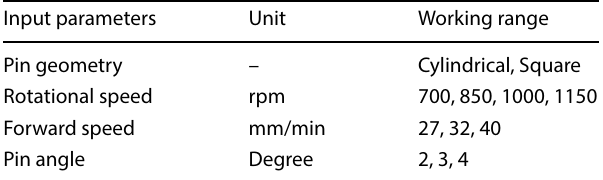
Table 2 The parameters of FSW